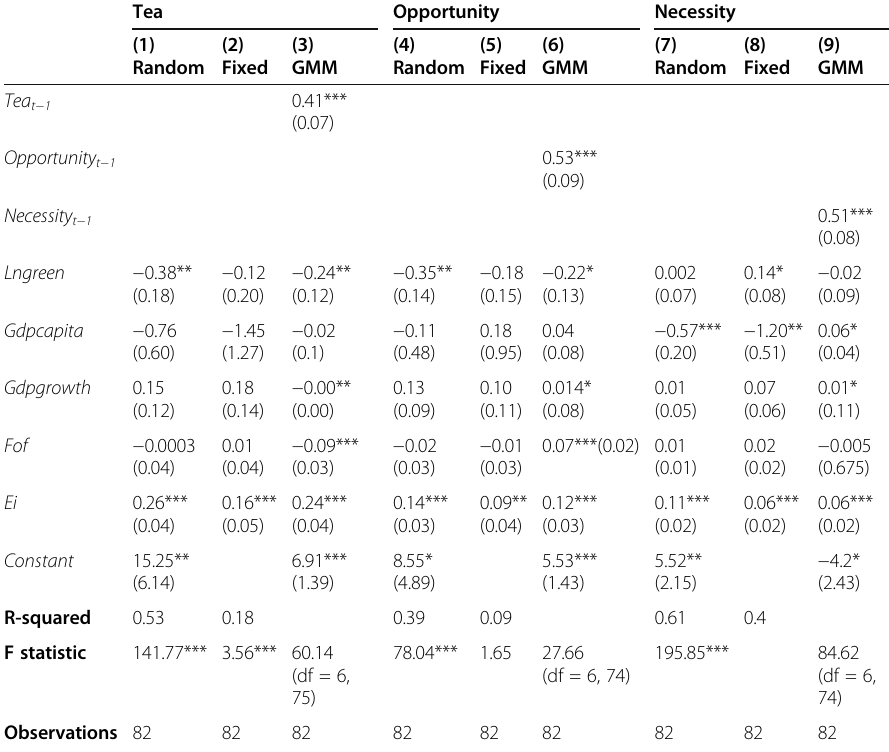
Table 4 Relationship between Greenfield investment and entrepreneurship in pre-crisis period Tea Opportunity